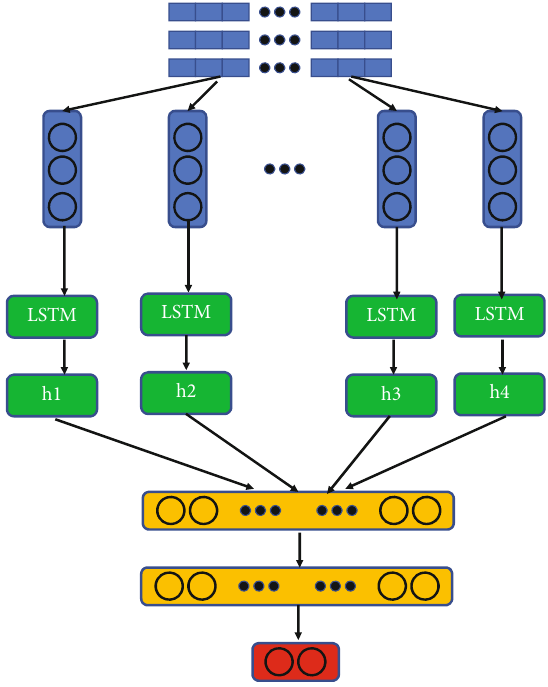
Figure 1: An example of the basic LSTM for stocking price